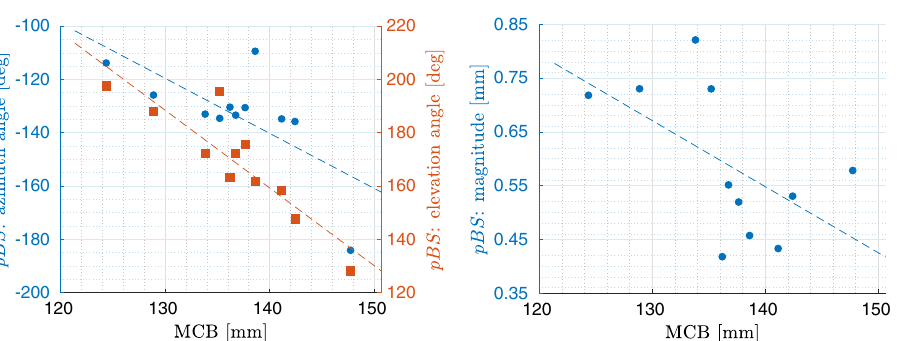
Figure 6. Diagonal components of strain averaged over some ROI: left (L) and right (R) anterior and posterior meninges (Men Ant, Men Post), frontal lobe (Front), temporal lobe (Temp), ventricles (Vent), parietal lobe (Par), occipital lobe (Occ). Blue lines represent the overall diagonal component (whiskers representing inter- subject variability), whereas the orange and yellow lines its deviatoric and volumetric components.